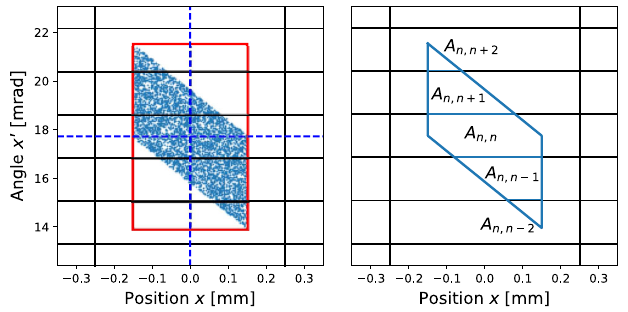
FIG. 8. Phase space region contributing to the data point at x ¼ 0 mm and V 0 ¼ 200 V (presentation format as detailed in Fig. 3), where the Allison scanner geometry corresponds to Case IV of Table I except for increased slit width to s ¼ 300 μ m. Scanning step sizes in x and V 0 are 0.5 mm and 20 V respectively.